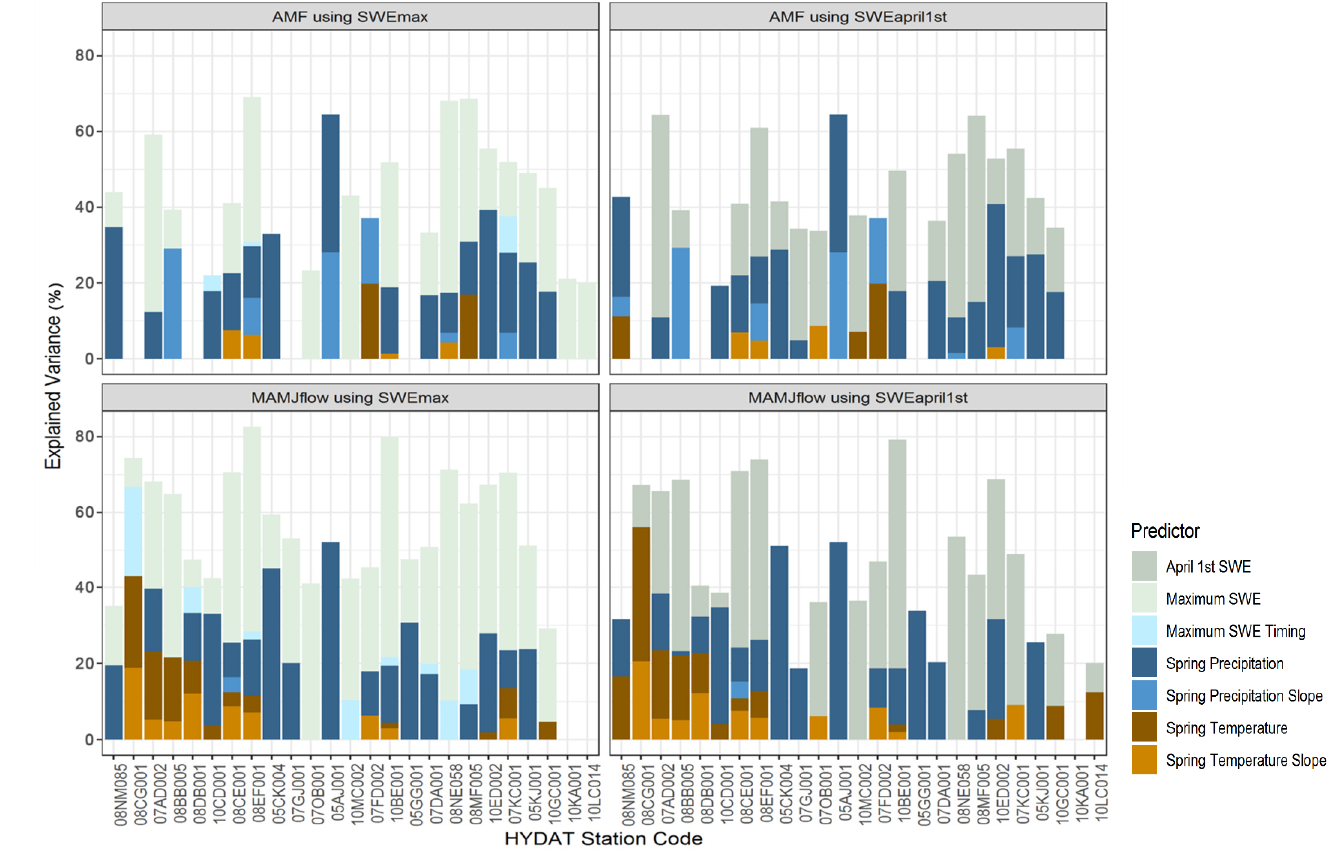
Figure 4. Relative importance of each predictor variable presented in terms of fraction of the explained variance in predicting annual maximum flow (AMF) and mean spring flow (MAMJflow) at each hydrometric station.